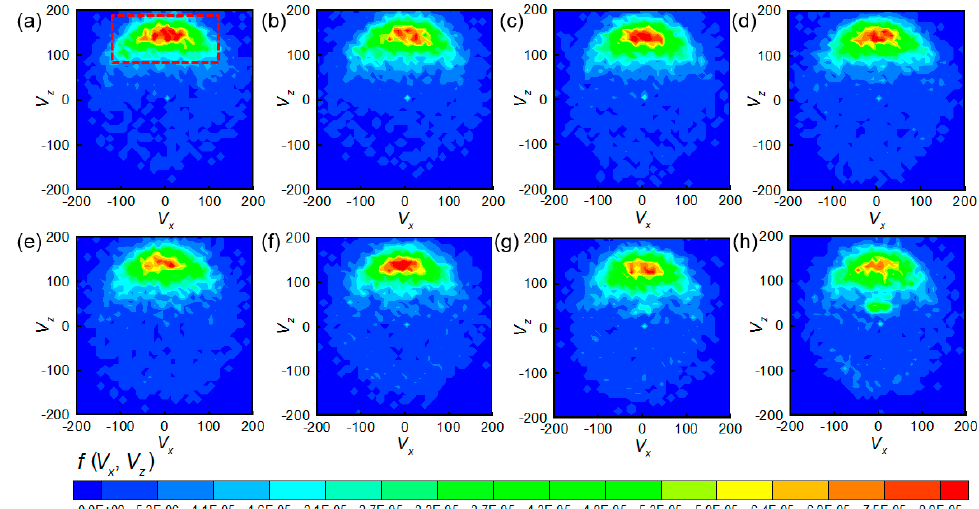
Figure 6. Distribution of f ( V x , V z ) at different time: ( a ) 20 min, ( b ) 25 min, ( c ) 30 min, ( d ) 35 min, ( e ) 40 min, ( f ) 45 min, ( g ) 50 min, and ( h ) 55 min.